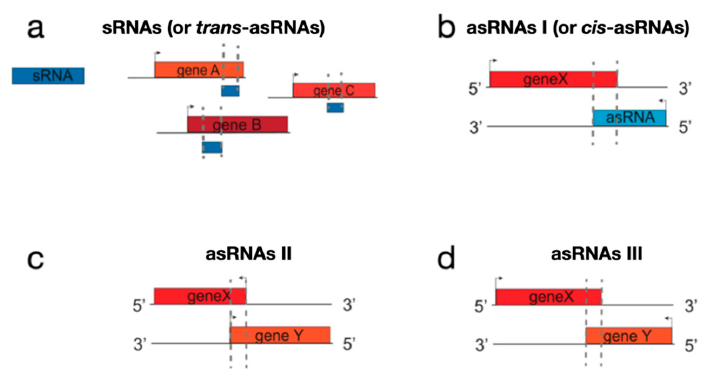
Figure 2. Scheme of ncRNA classes identified in this study. ( a ) sRNA; ( b ) asRNA I; ( c ) asRNA II; ( d ) asRNA III. Antibiotics 2021 , 10 , x FOR PEER REVIEW